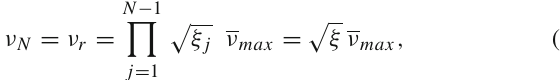
(i.e. H 1 = H max ). Even if, in general, H r (cid:6) H 1 we shall always require H r > 10 − 44 M P implying that the dominance of radiation takes place well before big-bang nucleosynthesis. During the i -th stage of the sequence the scale factor expands as a (τ) (cid:7) τ δ i . The dashed lines appearing in this cartoon correspond to the pivotal frequencies of the